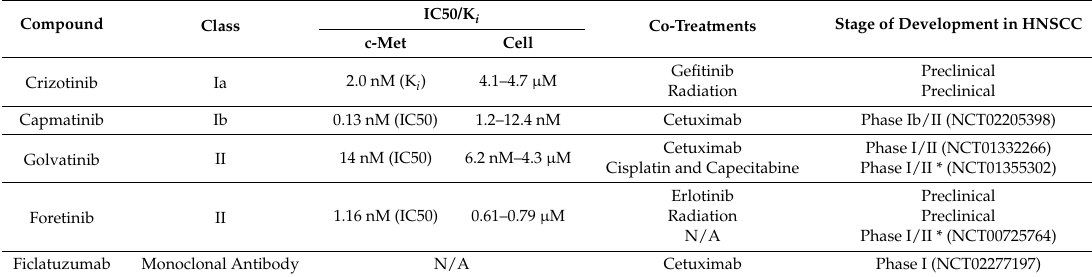
Table 1. Inhibitors of the HGF/c-Met axis under investigation in HNSCC.